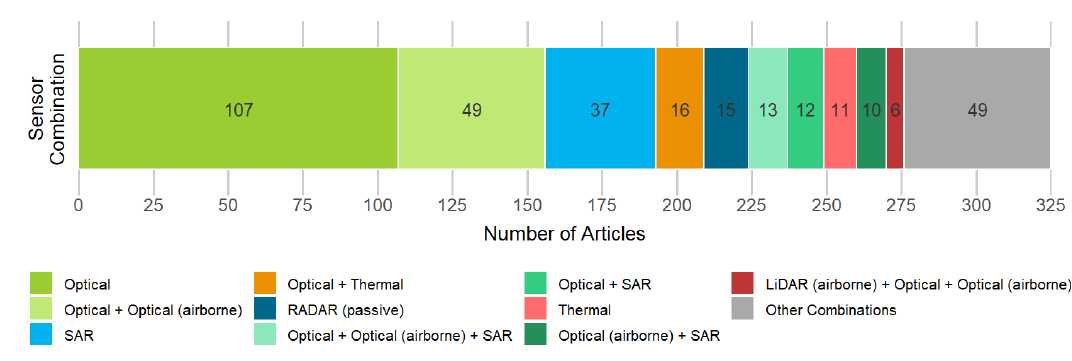
Figure 15. Frequency of the top ten most frequent sensor combinations analyzed within the reviewed articles. A differentia- tion between airborne and spaceborne sensor types was